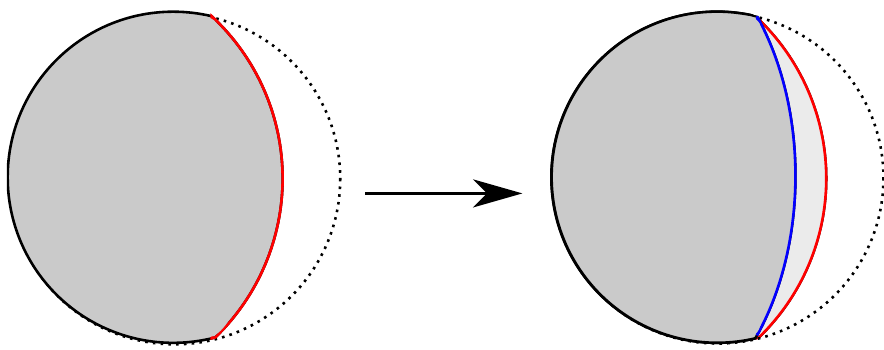
Figure 3 . Two putative bulk duals of holographic BCFT. Here, ETW branes are shown in red, and interface branes in blue; the shaded region is an asymptotically AdS Euclidean spacetime. The premise of this work is to move from the model depicted on the left to that depicted on the right, i.e. to introduce an additional interface